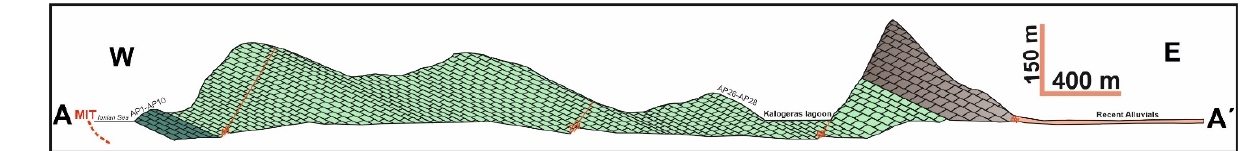
Figure 10. Cross-section showing the distribution of different formations in Araxos peninsula. For the location of cross- section see Figure 4, MIT: Middle Ionian Thrust (see Figure 1).